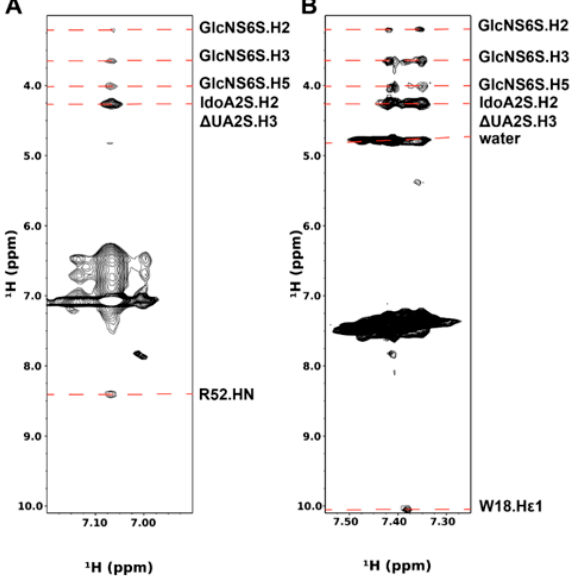
Figure 3. 15 N-edited NOESYHSQC of Arg and Lys side chains. ( A ) Strip of 15 N-edited NOESYHSQC of R52.H ε . ( B ) Strip of 15 N-edited NOESYHSQC of Lysine H ζ .